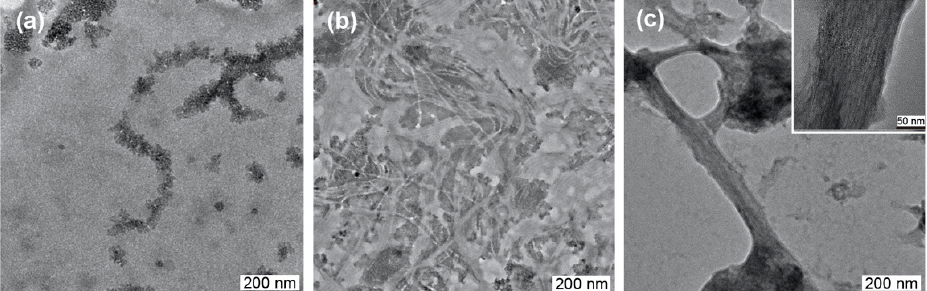
Figure 5. TEM images of 1Np-CMP 6 ( a ), An-CMP 6 ( b ) and Py-CMP 6 ( c ) assemblies formed in water (5% TFE) at 4 ◦ C. [CMPs] = 60 µ M. The images were obtained by staining with 1% phosphotungstic acid.